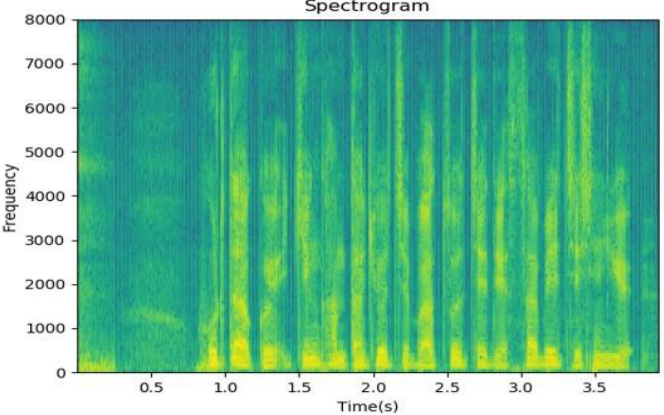
Figure 2. Structure of the language map.